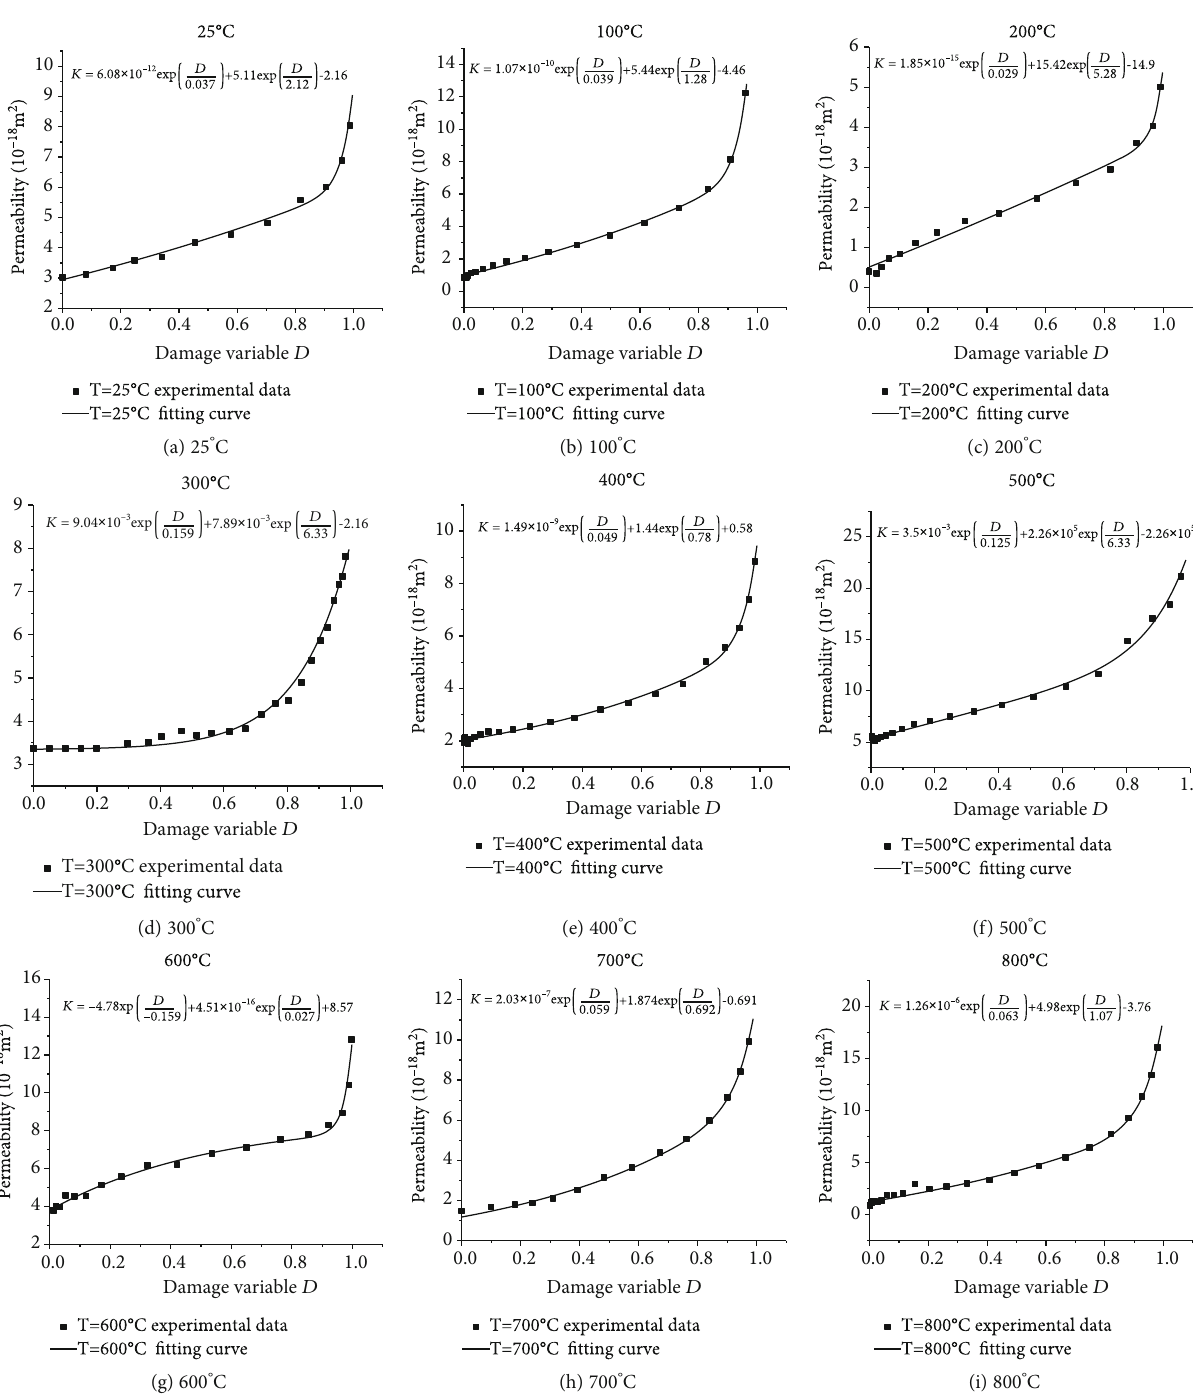
Figure 15: The permeability evolution the damage variables of the heat-treated